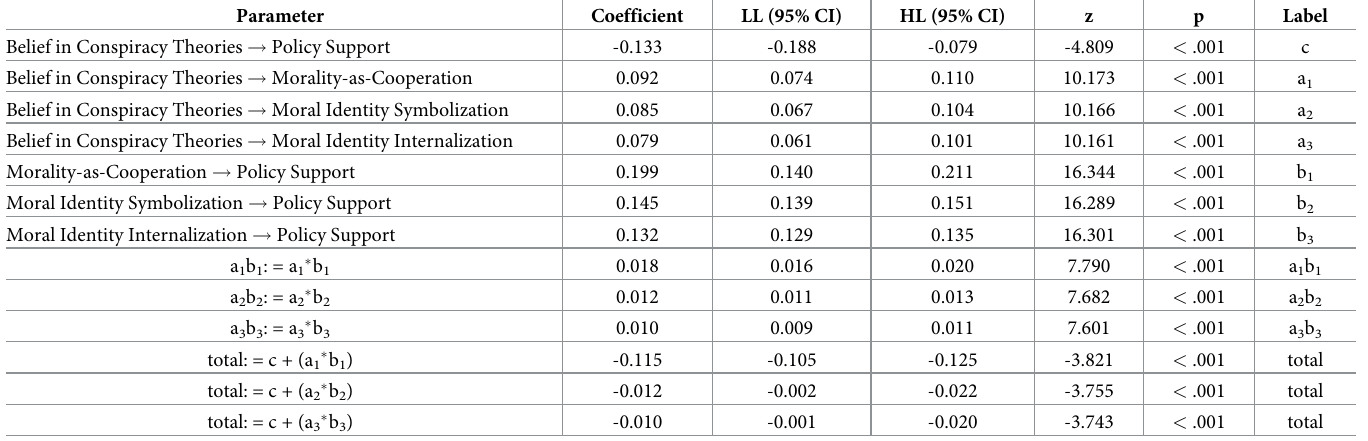
Table 5. Multilevel Mediation Analysis, model 3 (Policy